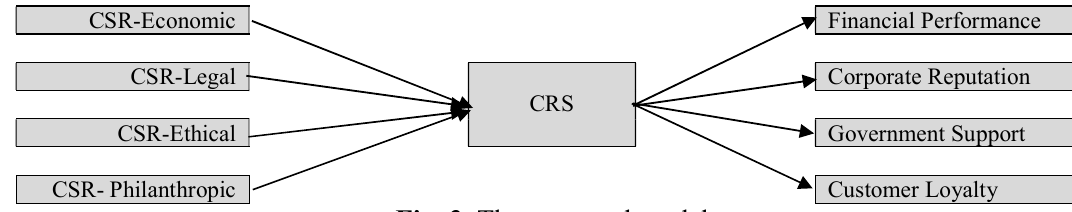
Fig. 3. The proposed